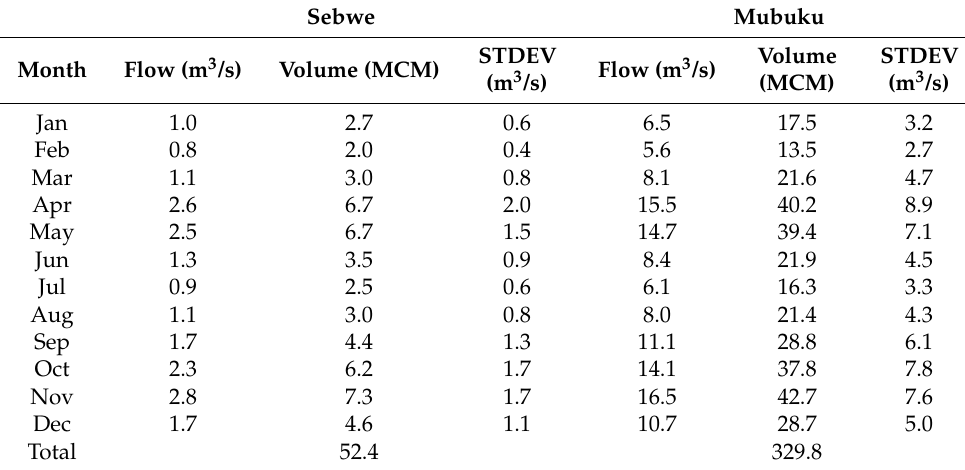
Table 5. Projected average monthly flow for Sebwe and Mubuku by